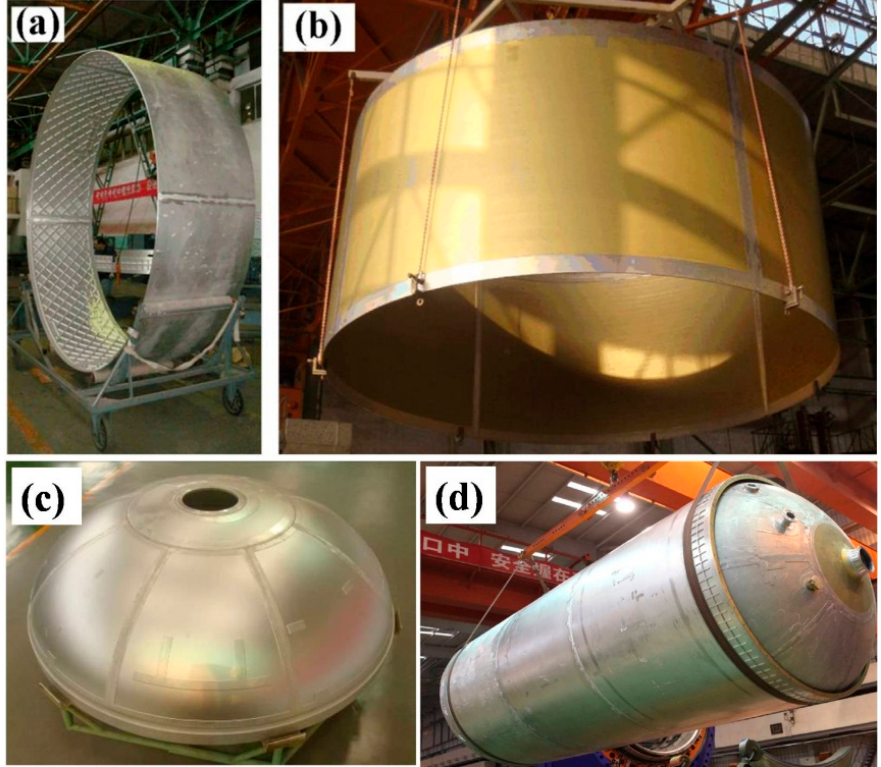
Figure 20. Application of FSW in longitudinal weld of tank section: ( a ) Φ 3350 section; ( b ) Φ 5000 section. ( c ) Application of FSW on Φ 3350 dome. ( d ) Application of FSW on Φ 3350 tank [45] (has permission from Elsevier).